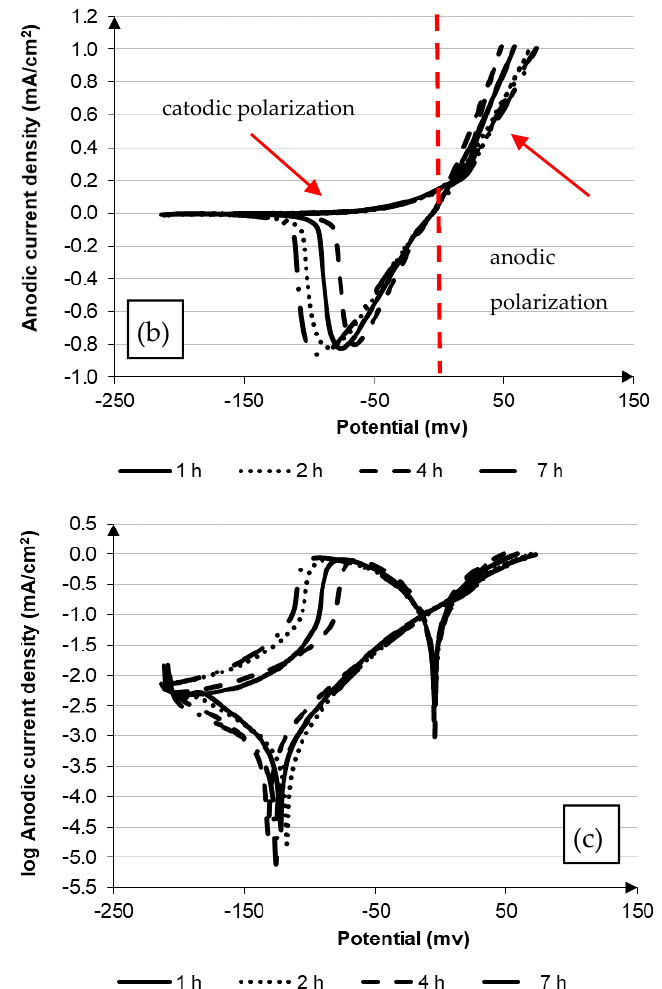
Figure 1. Electrochemical characteristics of the corrosion resistance test of aged samples at 600 °C: ( a ) potential of the open circuit, ( b ) anodic and cathodic polarization curve, ( c ) cycling potentiodynamic polarization curves with hysteresis loop (cathode and anode curves).